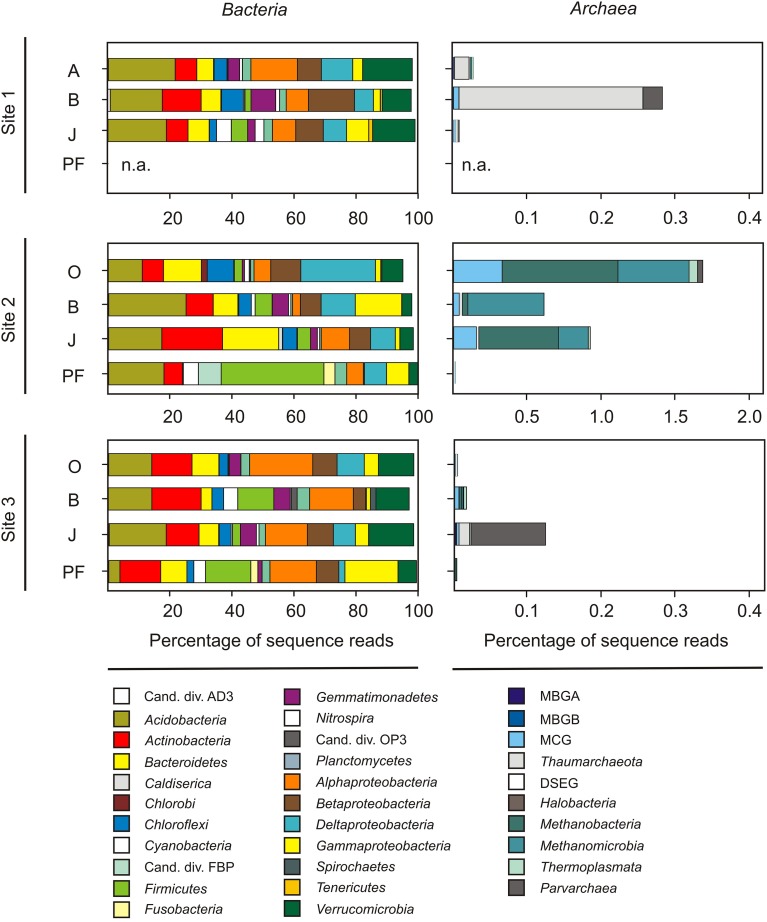
Community structure as revealed from Illumina tag sequencing of the prokaryotic V4 region of the SSU rRNA gene. Left panels: Percentage of OTUs affiliated to bacterial phyla, candidate divisions and proteobacterial classes (only shown if they represented at least 1% of all sequences in any of the samples). Right panels: Percentage of archaeal phyla, candidate divisions and classes. Cand. div., candidate division; MBGA, marine benthic group A; MBGB, marine benthic group B; MCG, miscellaneous crenarchaeotal group; DSEG, deep sea euryarchaeotal group; O, organic topsoil; A, mineral topsoil; B, mineral subsoil; J, buried topsoil; PF, permafrost layer. Note the difference in scaling of archaeal reads for site 2. (More detailed information the relative abundance of bacterial and archaeal classes in Table S3).